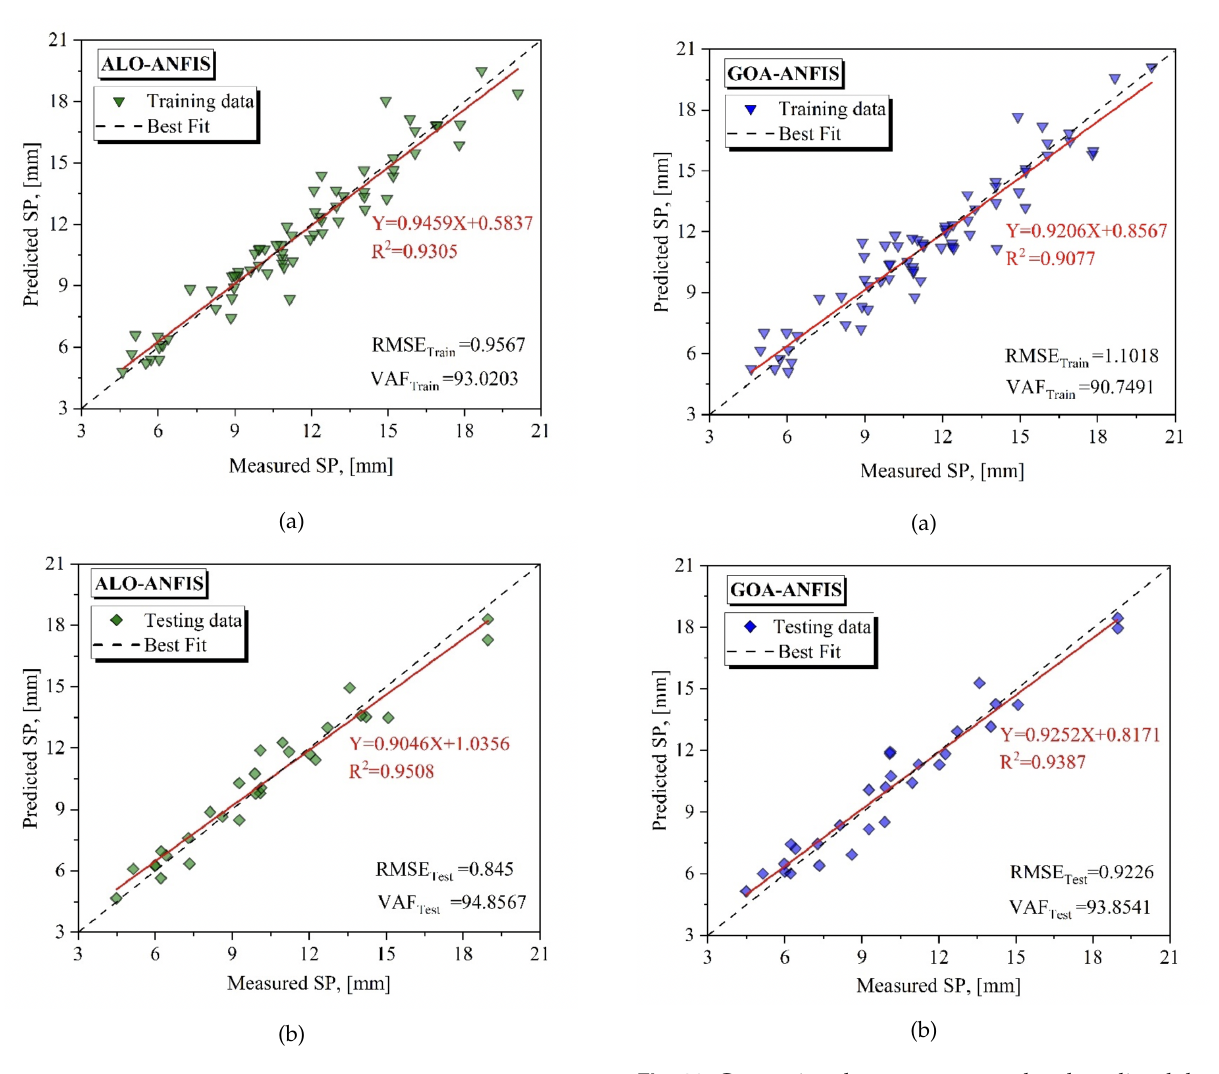
Fig. 10. Comparison between measured and predicted the pile settlement using ALO-ANFIS: a) Train; b) Test